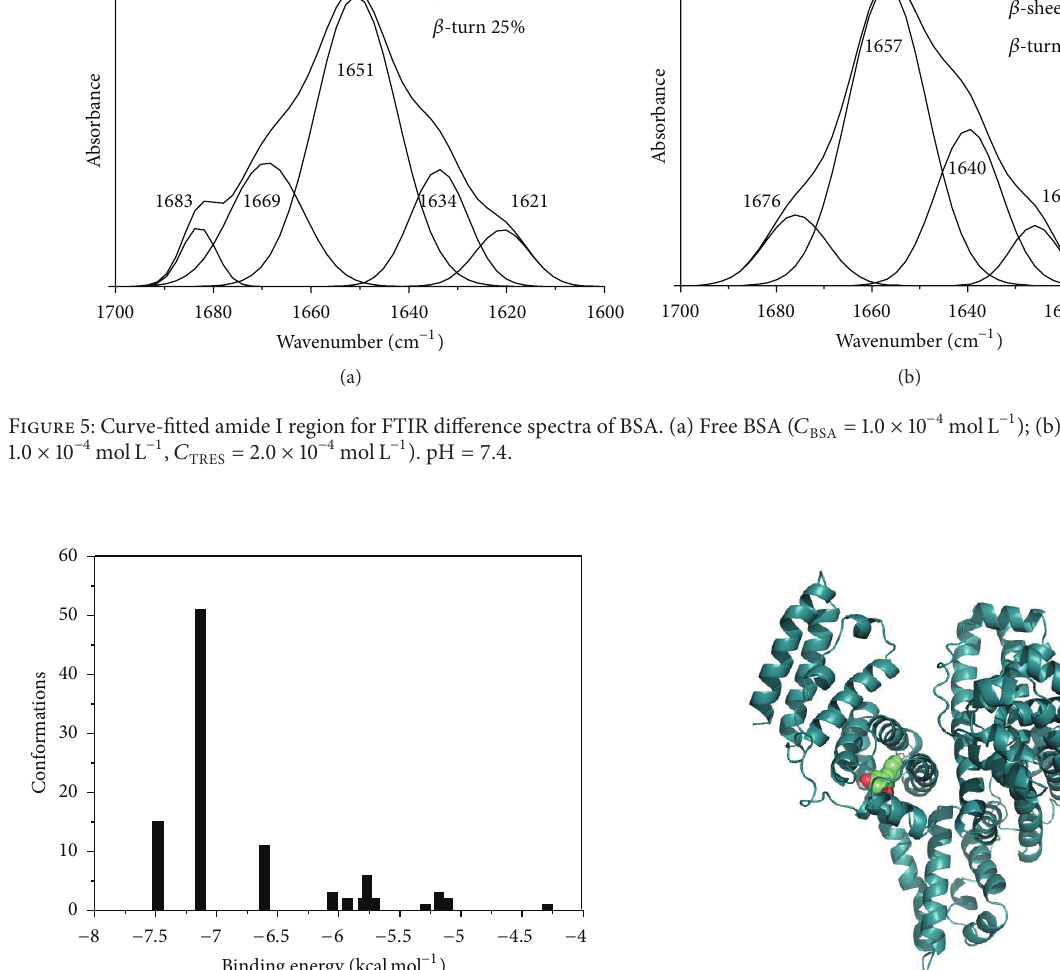
Figure 6: The clustering histogram at site II (RMSD: 2.0 ˚A). Figure 7: Best conformation for TRES docked to BSA. BSA is represented using cartoon ribbons and TRES is represented using